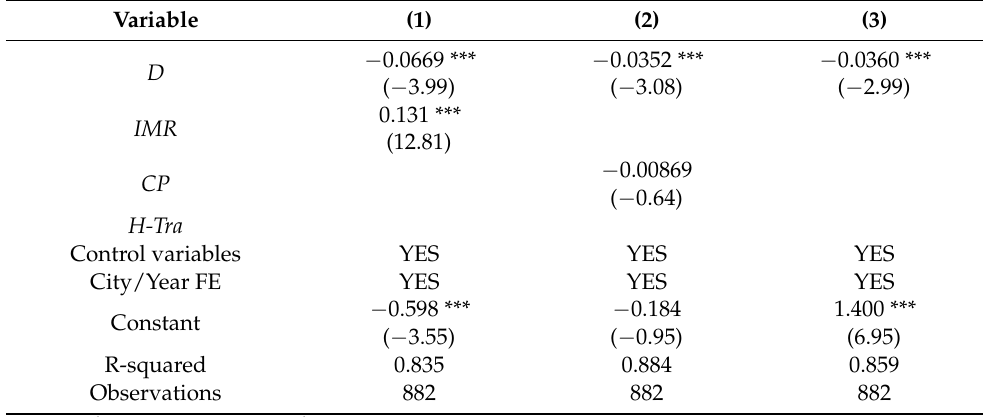
Table 5. Results of robustness